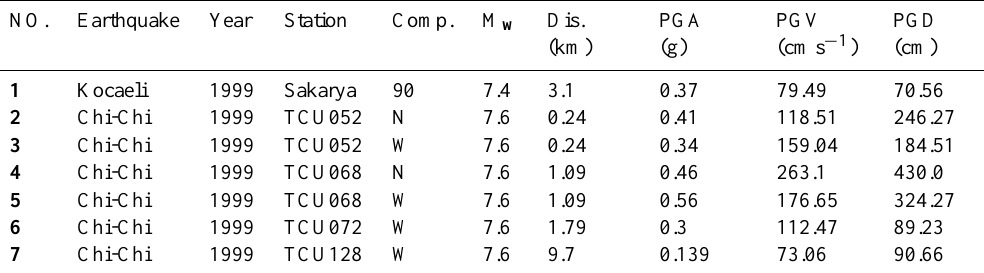
Table 5. Near-field ground motion database. Figure 13. Inter-storey drift for 10-storey building with (a) V/W=cte, (b) U